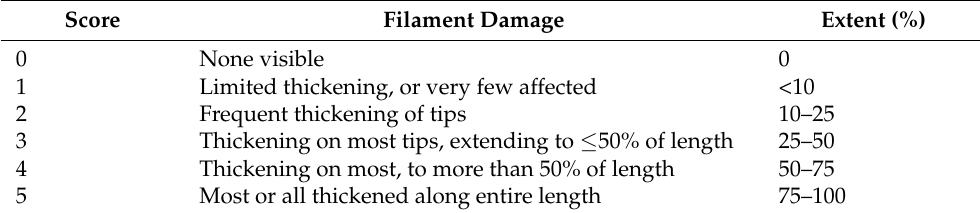
Table 1. Gross damage criteria used to assign a score to salmon